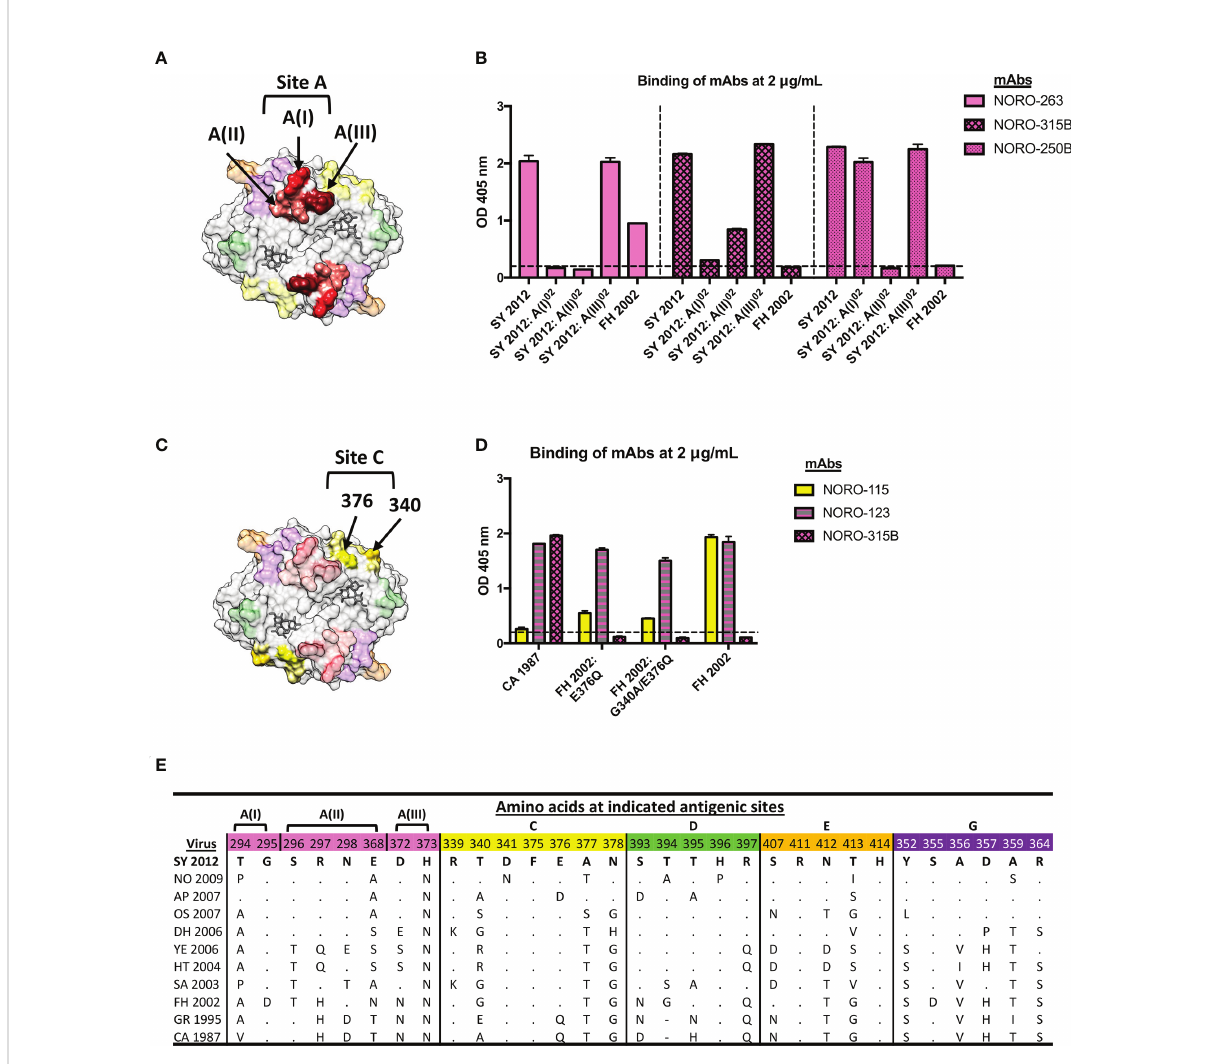
FIGURE 4 NORO-263, -315B, and -250B bind to motifs A(I) and/or A(II), while residues 376 and 340 contribute to the binding of NORO-115 to antigenic site C. (A) Structure of the P domain dimer (top view) with motifs A(I), A(II), and A(III) highlighted in red, pink, and maroon, respectively. The HBGA molecule is represented in dark grey. (B) Binding of mAbs NORO-263, -315B, and -250B to wt VLPs from Farmington Hills (FH 2002) and Sydney (SY 2012) variants, or to mutant VLPs with swapped motifs A(I), A(II), or A(III). Values represent the average binding at 2 m g/mL of each mAb. Each bar represents an average of duplicate wells. The dashed line represents the cut-off value (OD 405 nm = 0.2). The error bars represent the standard deviation of the mean. (C) Structure of the P domain dimer (top view) with residues 376 and 340 from antigenic site C (yellow) highlighted in gold. An HBGA molecule is represented in dark grey. (D) Binding of mAb NORO-115 to wt VLPs from Farmington Hills (FH), Camberwell (CA) variants, or to mutant VLPs presenting the backbone of FH variant with residues exchanged with the CA variant (FH 2002: E376Q and FH 2002: G340A/E376Q). The error bars represent the standard deviation of the mean. (E) Sequence alignment of antigenic sites A, C, D, E, and G from selected GII.4 viruses. CA, Camberwell; GR, Grimsby; FH, Farmington Hills; SA, Sakai; HT, Hunter; YE, Yerseke; DH,